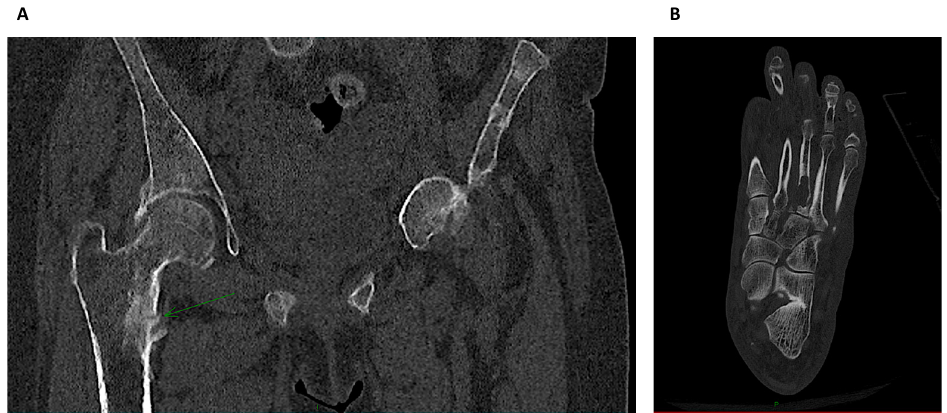
Figure 4. Computerized tomography images: ( A ) The arrow shows a femoral metaphyseal stress fracture distal to the lesser trochanter in a hemodialysis patient with osteomalacia. Computerized tomography is mainly used to diagnose nonobvious fractures that can allow a non-surgical approach. ( B ) Image of a “brown tumor” in the proximal zone of a metatarsal bone.